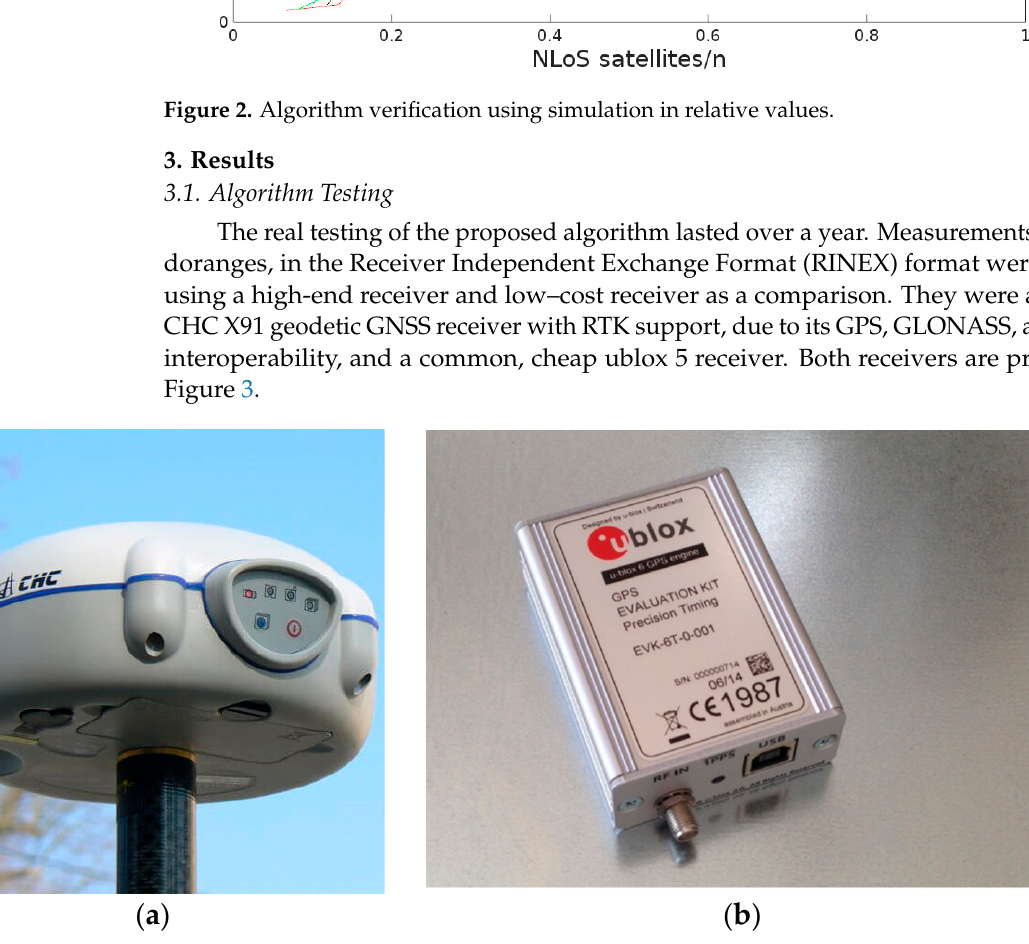
Figure 3. GNSS receivers used for testing. A CHC x91 geodetic receiver ( a ) and an ublox receiver ( b ).